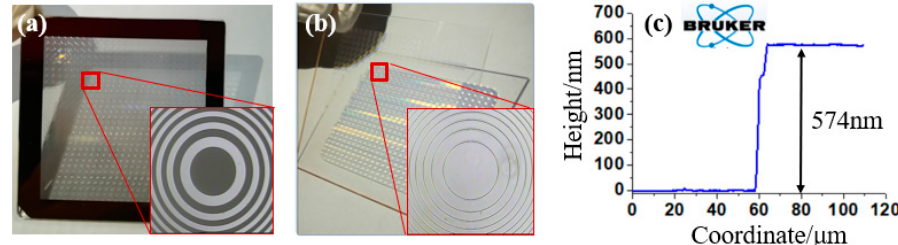
Figure 4. Key fabrication results, including: ( a ) mask; ( b ) prototype based on silica; ( c ) measurement of the fabricated structure by a step proflometer.